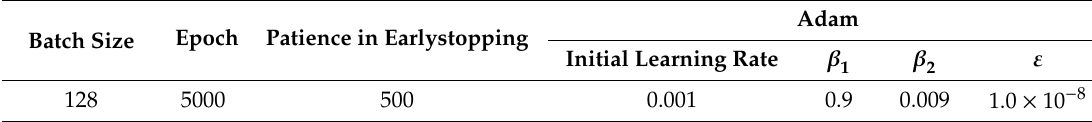
Table 3. The training parameters of CNN structure in this work.